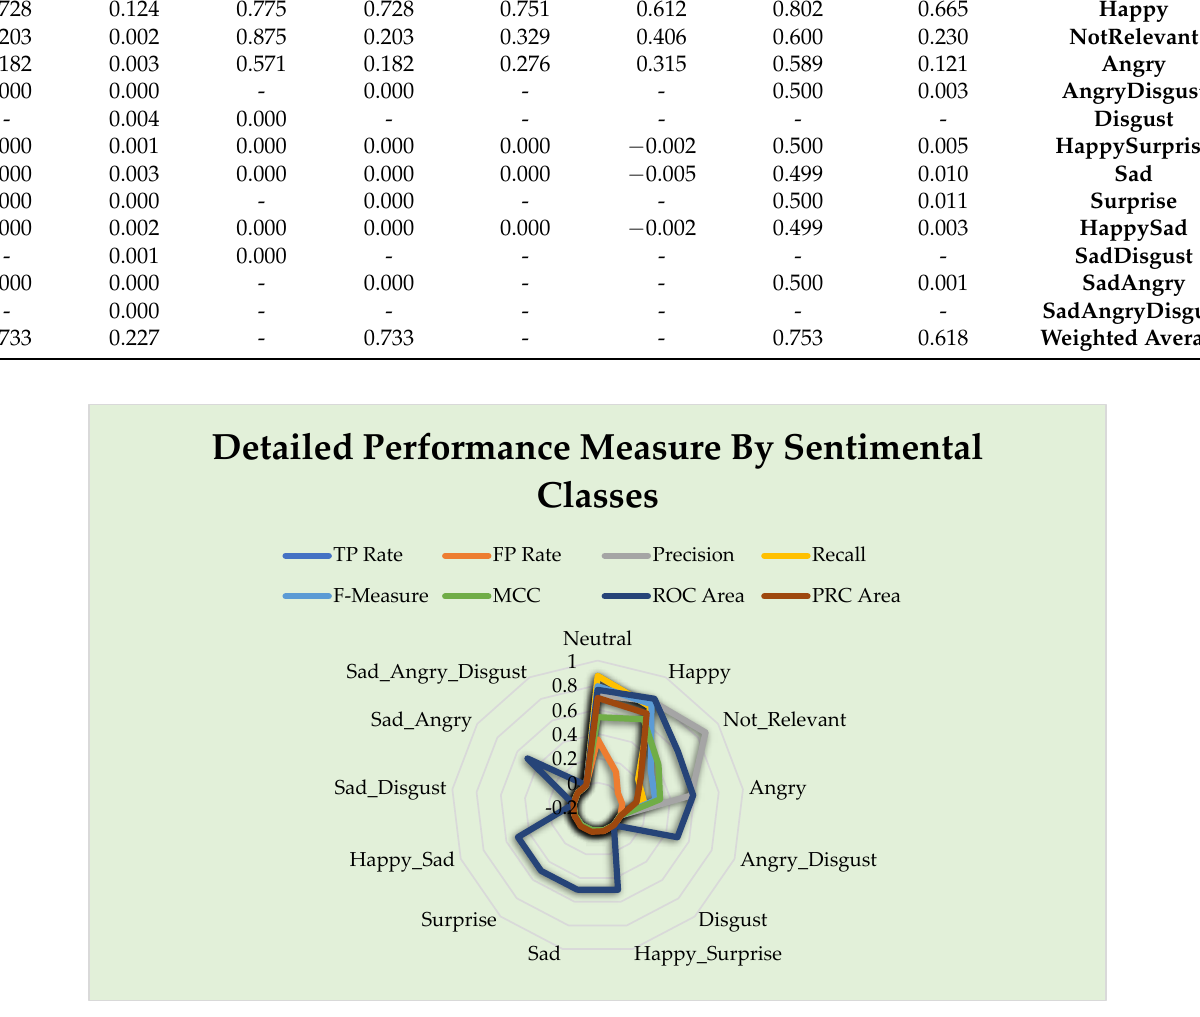
Figure 6. Detailed accuracy by class (single feature selection techniques). Table 5 represents the confusion matrix by class using a single feature selection tech- nique in combination with LL, and its graphical representation is shown in Figure 7. Table 5. Confusion matrix by class (single feature selection technique).